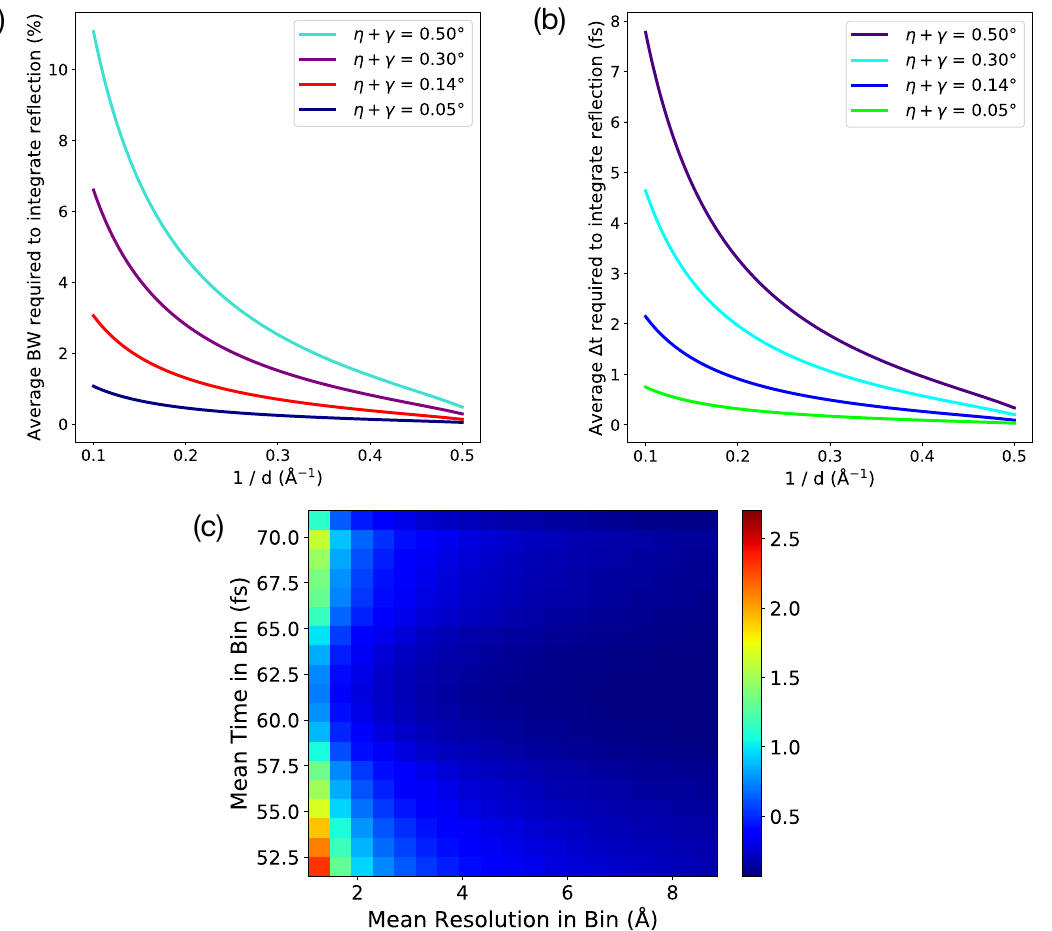
Figure 4. Requirements for full reflection integration. ( a ) Calculated values of BW req as a function of resolution for four effective mosaic spreads ( η + γ ). ( b ) Time interval required to integrate a reflection at different resolutions for four effective mosaic spreads. ( c ) Ratio of available to required bandwidths for each 1-fs time bin at different